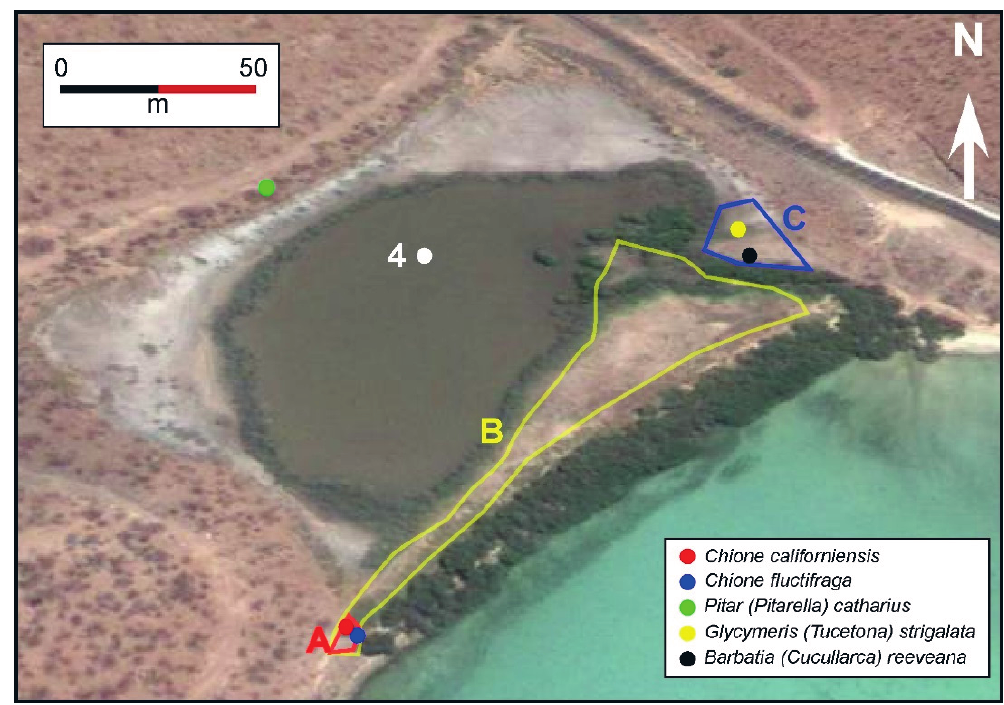
Figure 3. Marine deposits along the southern (seaward) edge of the lake. Three areas of interest are marked, as are the locations of the dated shells and core 4.